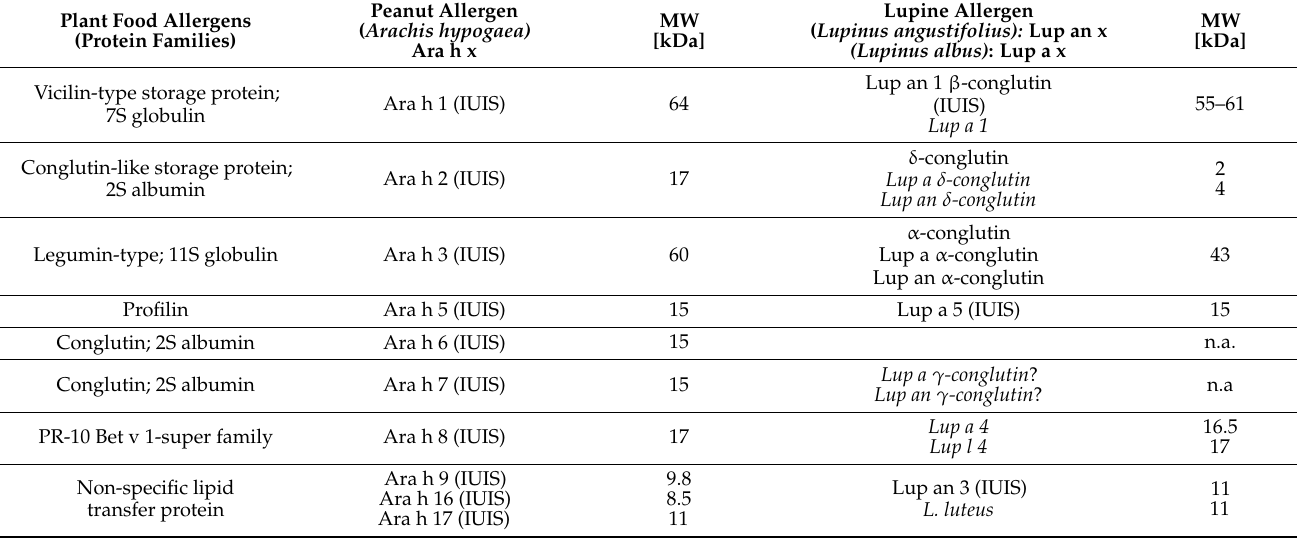
Table 2. Synopsis of single allergens in lupine species compared to peanut